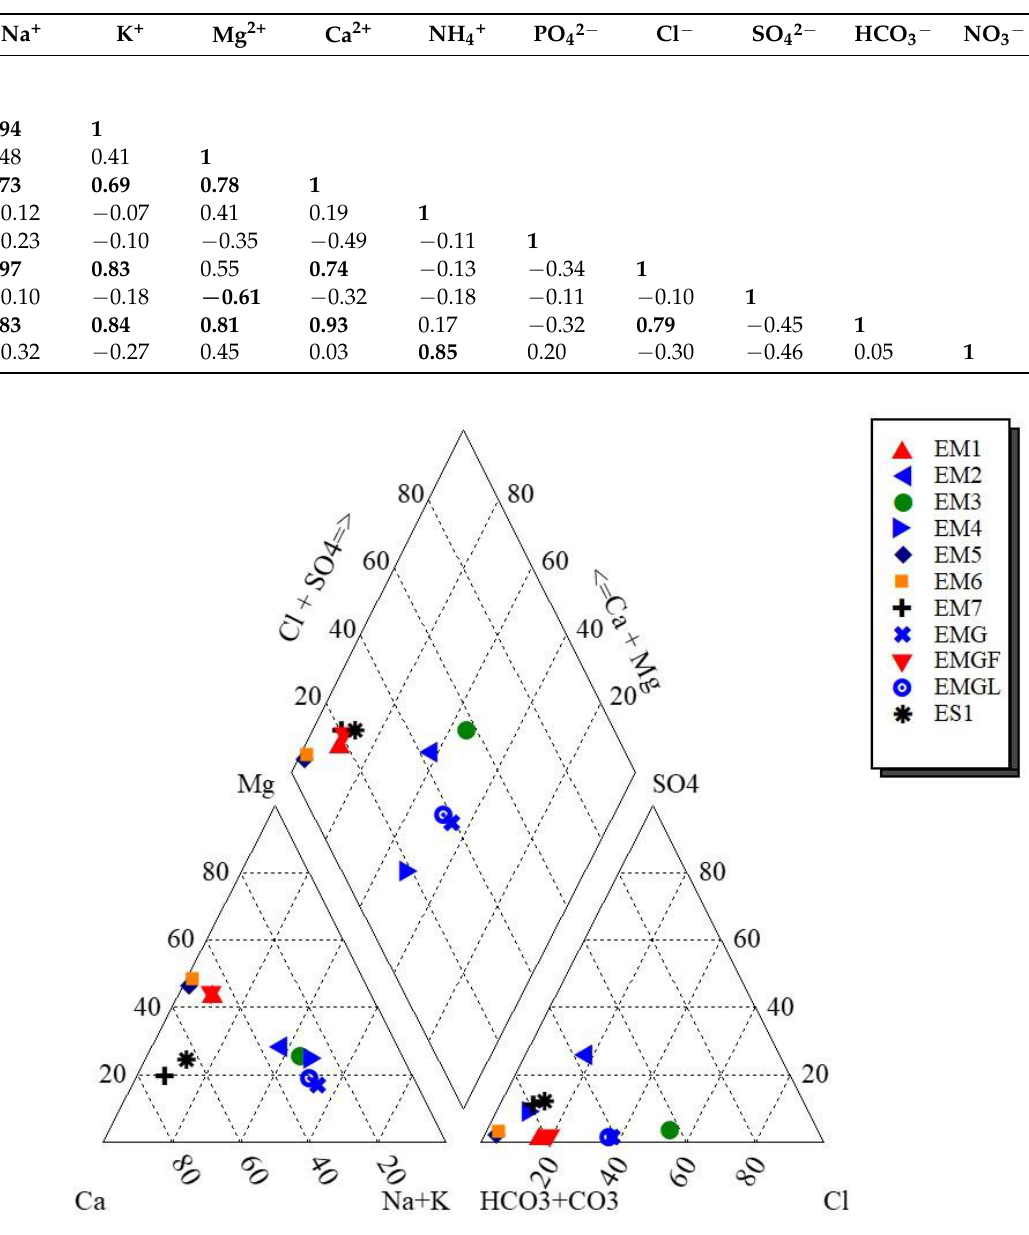
Table 3. Correlation coefficient matrix between the different chemical parameters of bottled water in Morocco. The bolded values ≥ 0.6 correspond to strong and representative relationship between 2 parameters.